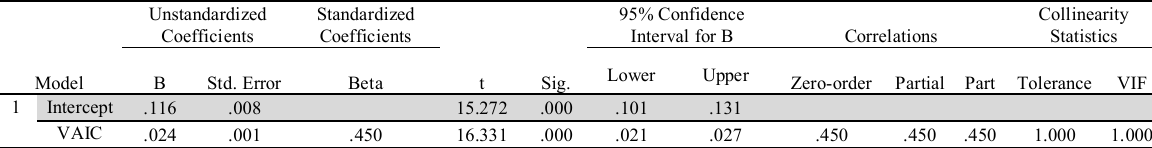
The summary of regression model